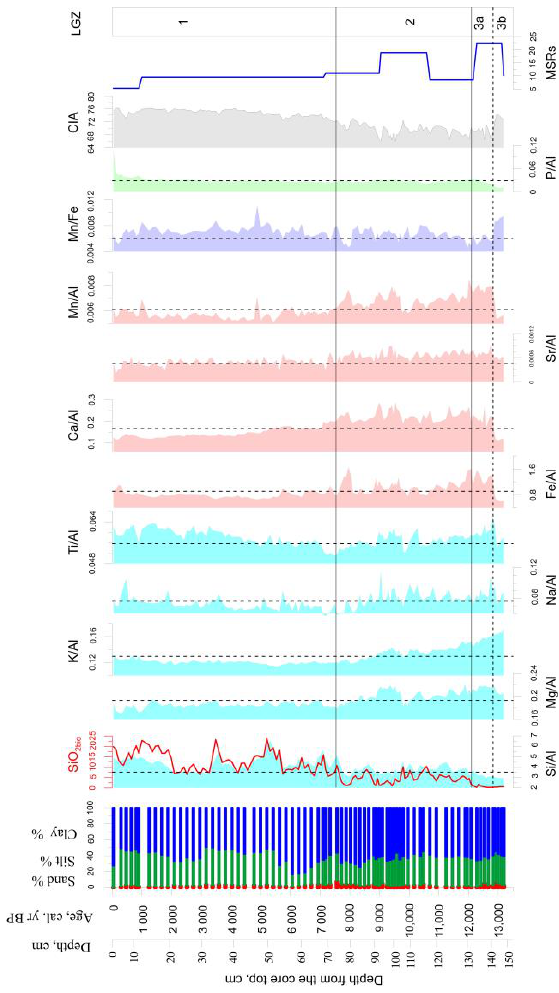
Figure 4. Changes in selected sediment characteristics and geochemical indices of the Lake Kaskadnoe-1 core. Vertical dotted lines indicate mean ratio values. Mean sedimentation rates (MSRs) were calculated between adjacent dates and are expressed in cm per 1000 years. Three local geochemical zones (LGZ 1–3) with differing geochemical records were identified based on the statistical evaluation of samples by principal component analysis (PCA) and demonstrated good agreement with LGZ 1‒3 boundaries identified by the CONISS program. Subzones within LGZ -3 were identified by visual inspection.